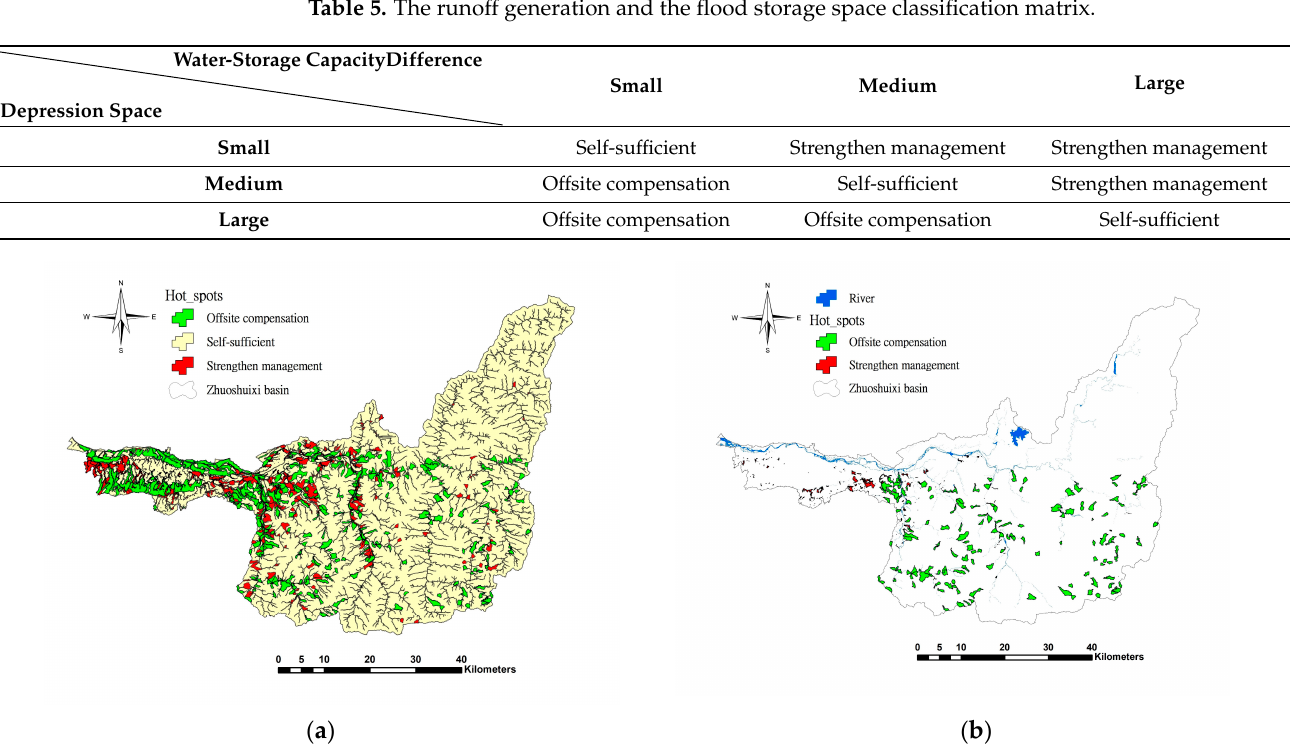
Table 5. The runoff generation and the flood storage space classification matrix.